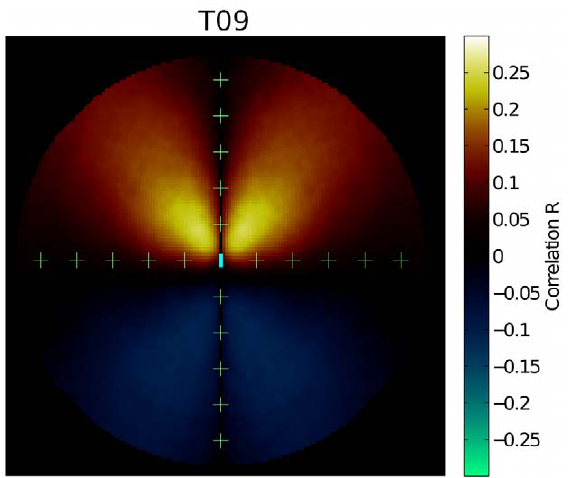
Figure 7. Correlation map between the observed turning angle a and the angle S a T predicted using pheromone information at positions D x and D y (equation 7). The colour associated with each point ( D x , D y ) represents the value of the correlation coefficient between the observed turning angle ½ a 1 , a 2 ,, a N (cid:2) and the turning angles predicted from equation 5 ½ S a 1 T , S a 2 T , ::: , S a N T (cid:2) . The ant is situated in the centre of the map, facing upwards, and its approximate dimensions are given by the cyan rectangle. The scale for the figure is provided by + symbols, which are spaced 1 cm. apart. The map is for trial T09 and no pheromone evaporation. Similar maps are found in all the